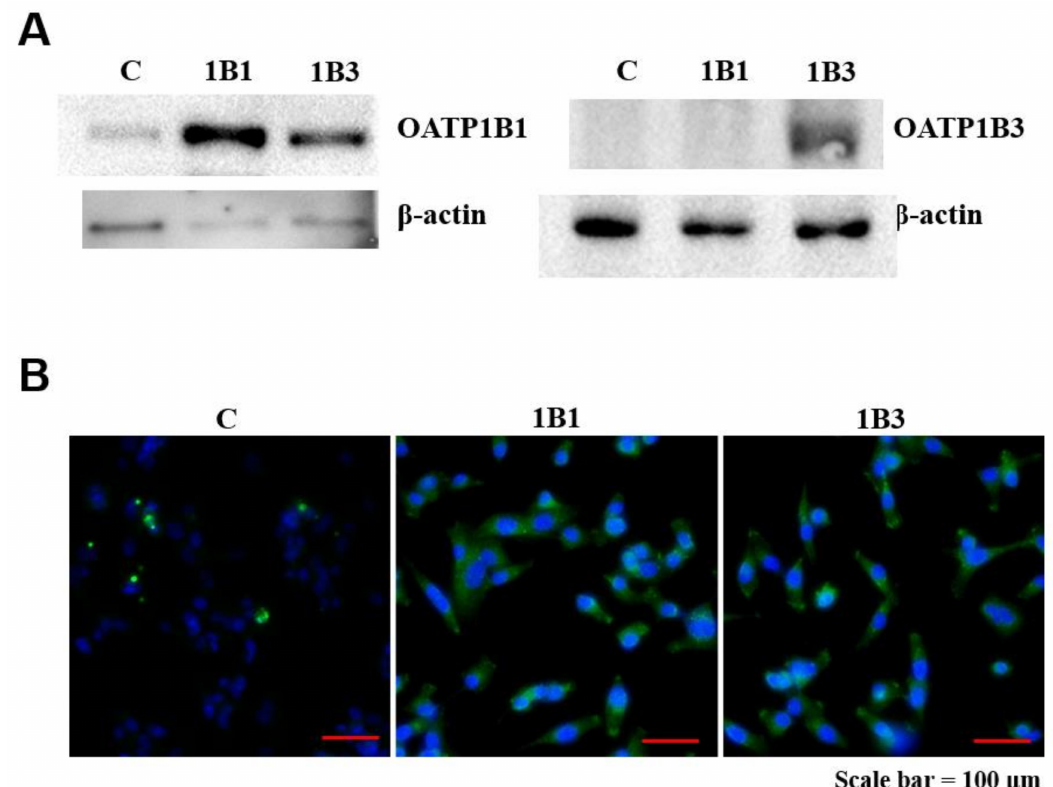
Figure 4. Protein expression of OATP1B1 and OATP1B3. ( A ) Western blot analysis of OATP1B1, OATP1B3, and control β -actin for OATP1B1-expressing, OATP1B3-expressing, and control cells. ( B ) Fluorescence microscopy displaying staining for OATP1B1, OATP1B3 (green), and nuclei control (blue). C, control; 1B1, OATP1B1-expressing cells; 1B3, OATP1B3- expressing